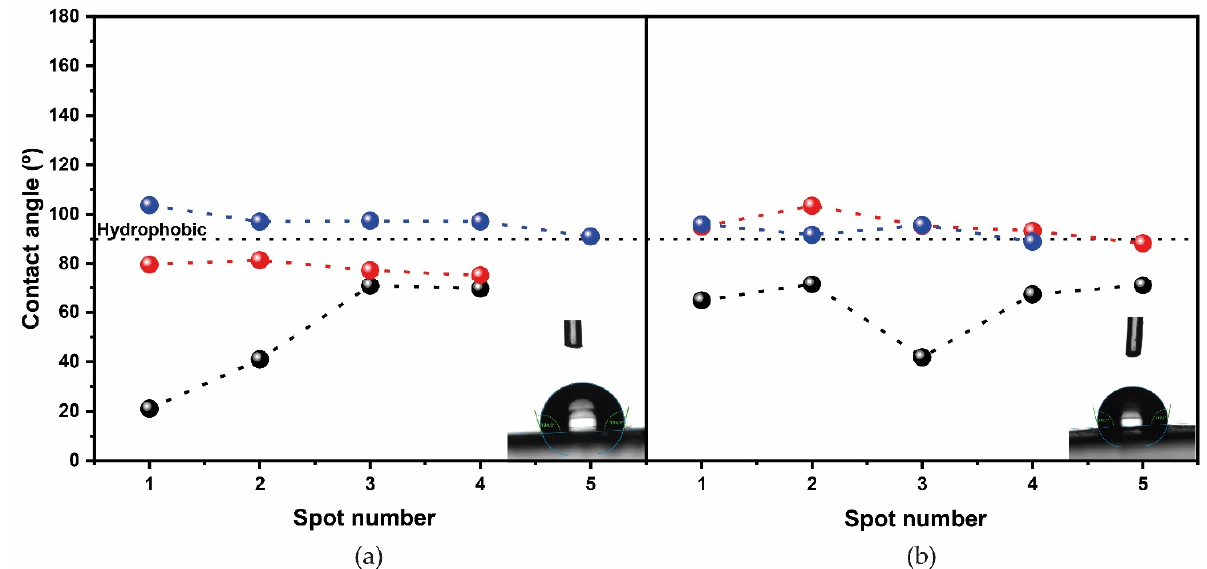
Figure 3. Water contact angle, in static mode, of d-U(600) ( a ) and d-(900) ( b ) based di-ureasils. Non- doped materials (black symbols), materials doped doping with LiBF 4 and [Bmim]Cl (red symbols) and materials doped solely with [Bmim]Cl (blue symbols).